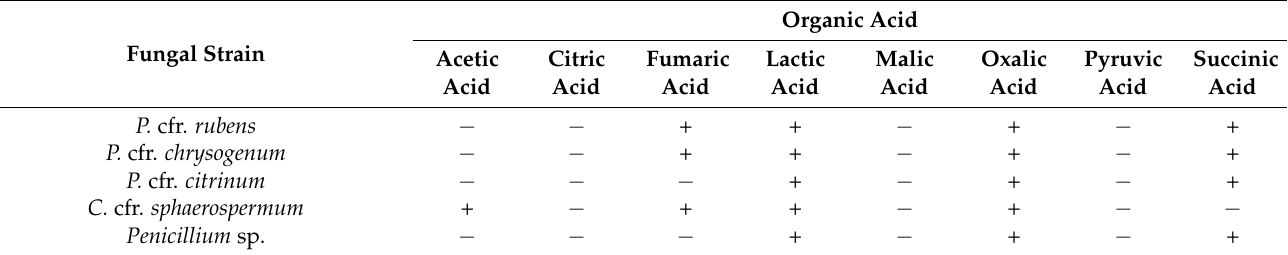
Table 1. Secretion profiles of different types of organic acids for selected fungal strains.